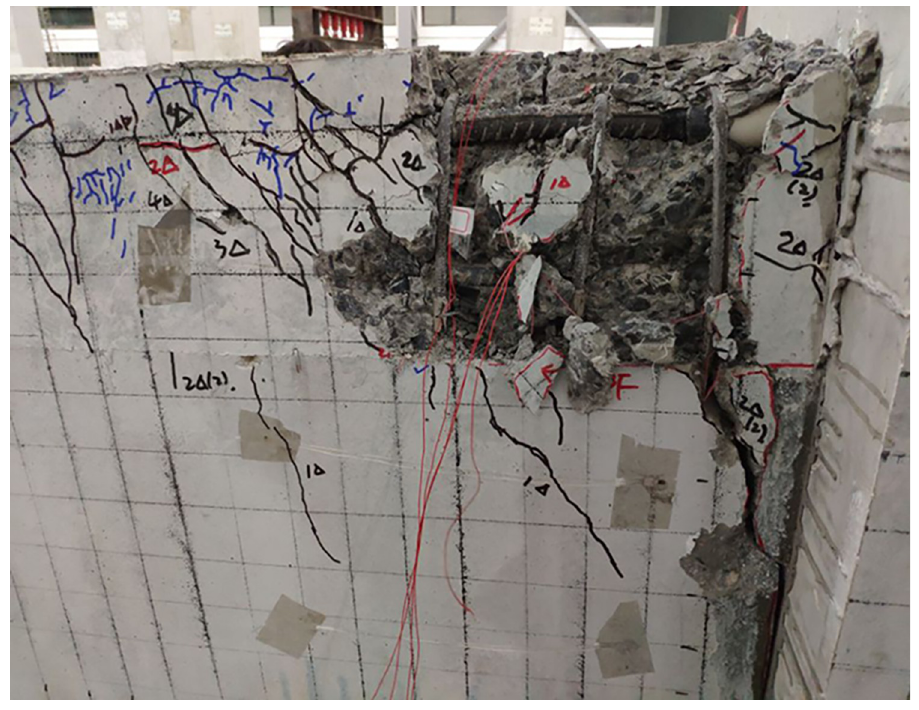
Fig 14. Failure mode of